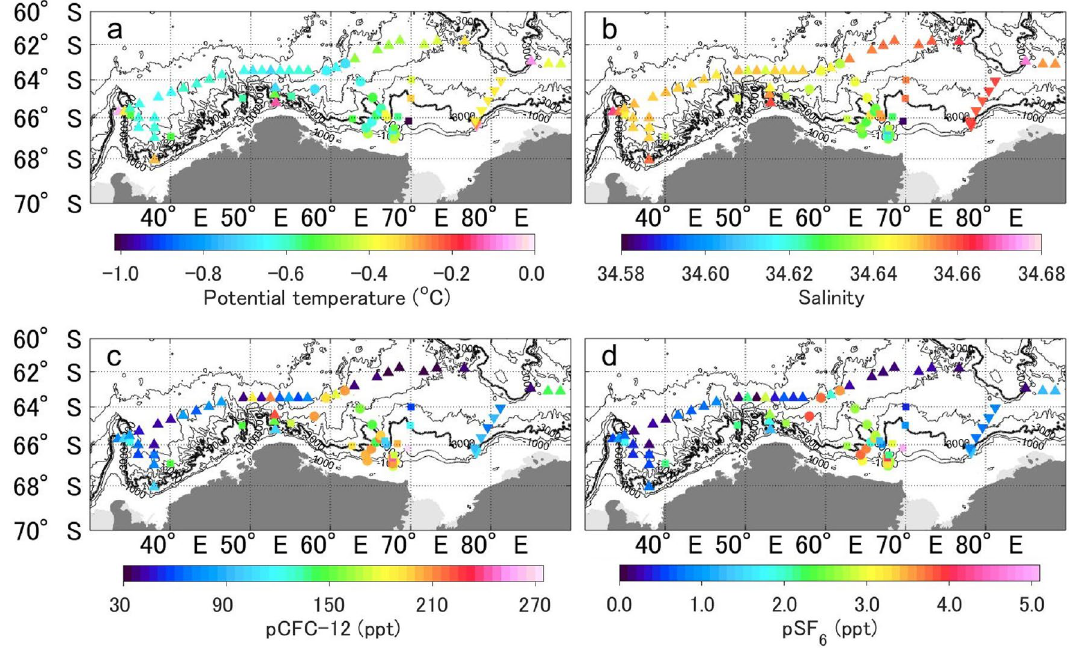
Figure 3. Spatial distributions of bottom ( a ) potential temperature, ( b ) salinity, ( c ) pCFC-12, and ( d ) pSF 6 of the AABW (neutral density: γ n > 28.27 kg m −3 ) (mean of observations within 100 m of the bottom). The symbols used are the same as in Fig. 1. Note that pSF 6 in the atmosphere increased by 20% between 2013 and 2020. Therefore, the distribution of pSF 6 in AABW can vary considerably among observation years. Black contour lines represent isobaths at 1000 m intervals from 1000 to 3000 m and at 500 m intervals below 3000 m. The 3000 m isobath is indicated by the thick black line. The figure was generated using MATLAB (version R2021a; https:// www. mathw orks. com/ produ cts/ matlab. html) and the M_Map toolbox (http:// www. eoas. ubc. ca/ ~rich/ map.